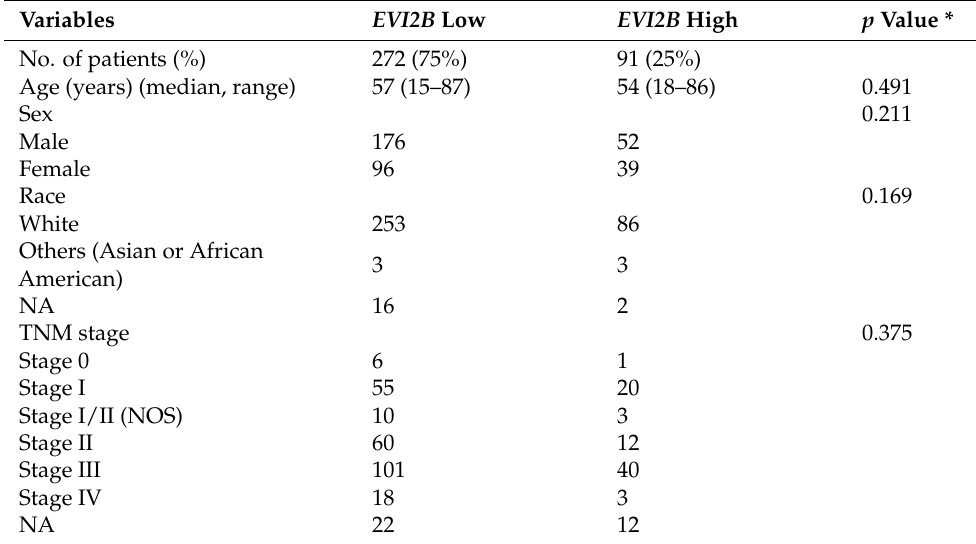
Table 1. Multivariate Cox regression analysis on overall survival on TCGA